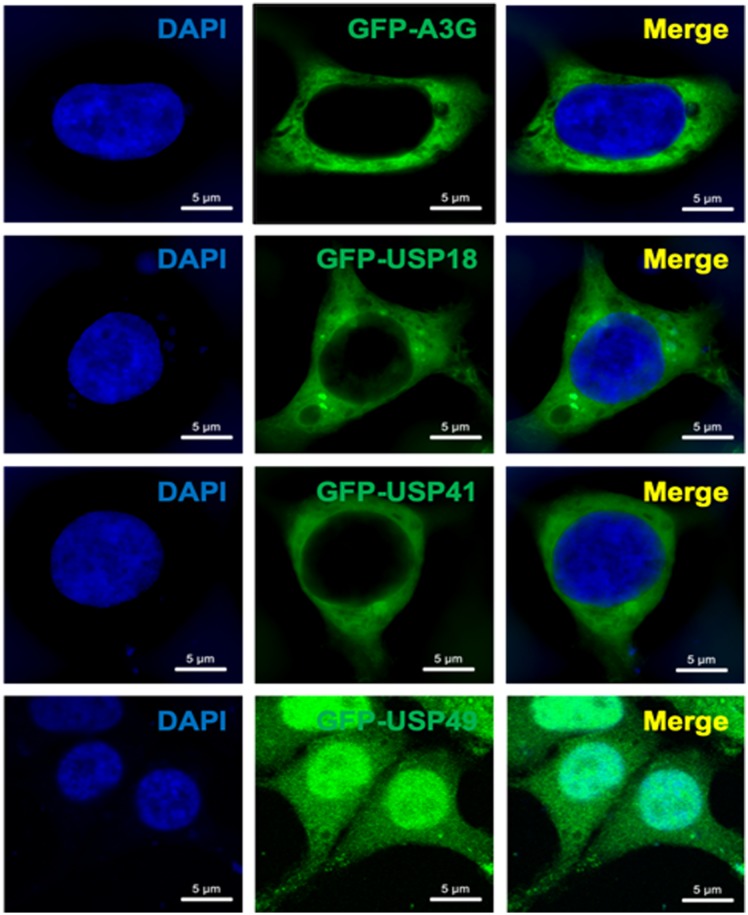
The distribution of GFP-tagged DUBs and A3G protein.HEK293T cells were transfected with plasmids expressing USP18-GFP, USP41-GFP, USP49-GFP, and A3G-GFP respectively. After 48 hr, the cells were fixed with 4% paraformaldehyde, and the distribution of DUBs and A3G was detected using a Confocal Microscope.